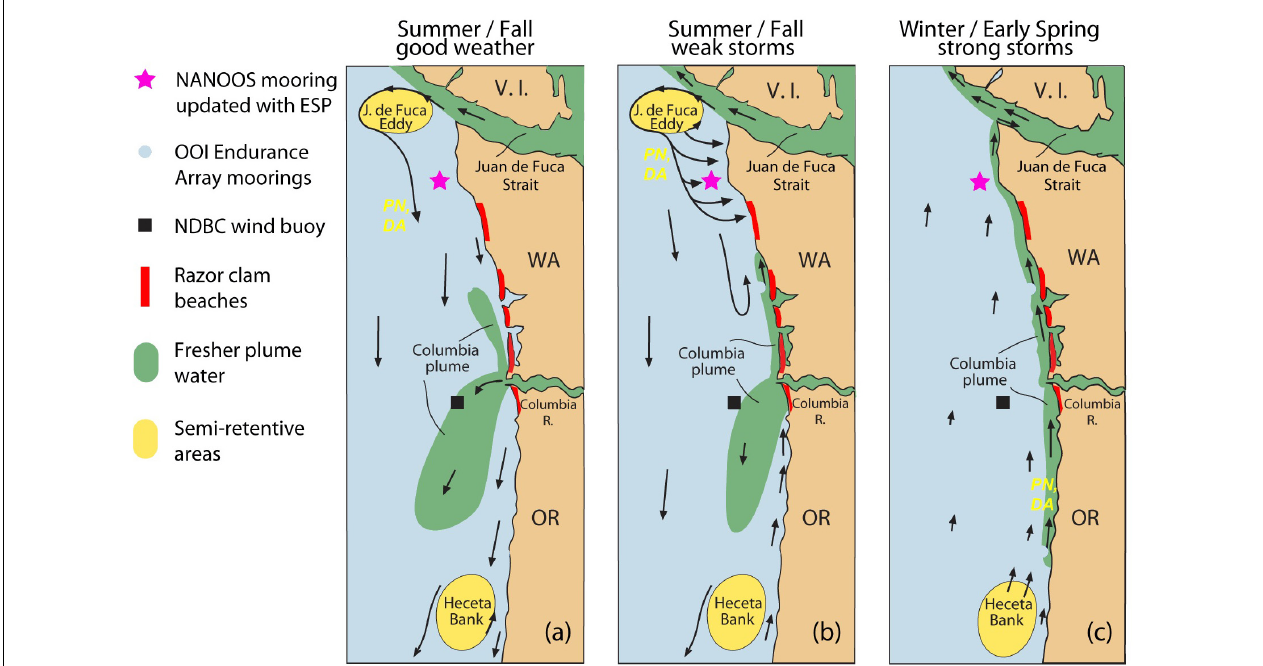
FIGURE 1 | Schematic diagram of the outer Washington coast showing the locations of semi-retentive oceanographic features that are known to be HAB initiation sites (i.e., the Juan de Fuca eddy and Heceta Bank), ocean observing platforms, razor clamming beaches, and the transport pathways during (a) summer/fall good weather, (b) summer/fall weak storms, and (c) winter/early spring strong storms. PN and DA are Pseudo-nitzschia and domoic acid, respectively, and indicate the pathways that toxic HABs can take from HAB initiation sites to coastal beaches. Figure modified from Hickey et al. (2013).